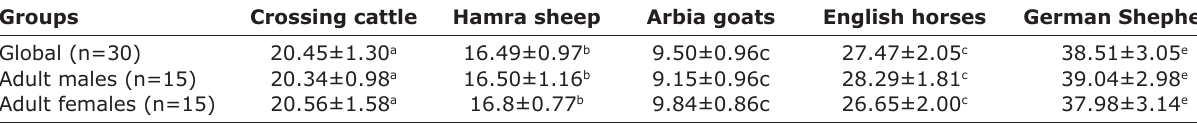
Table-6: Influence of red blood cells surface on the species determination of pets (Group 2, expressed in μ m 2 ).